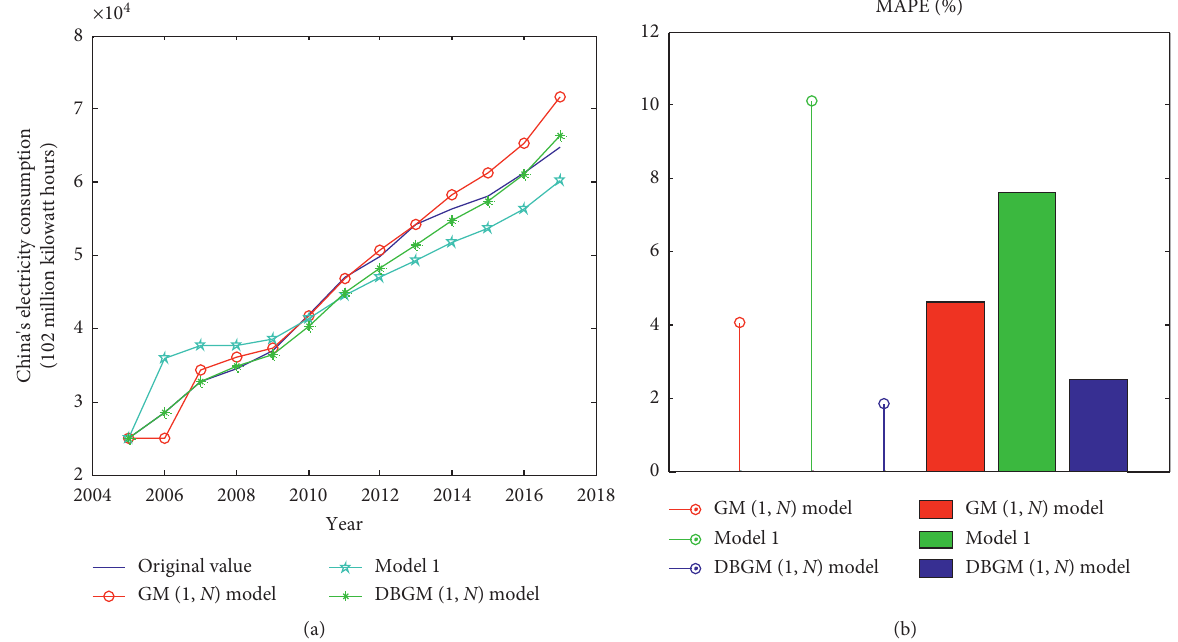
Figure 1: Schematic of the prediction results and MAPEs of the three prediction models (Case 1).